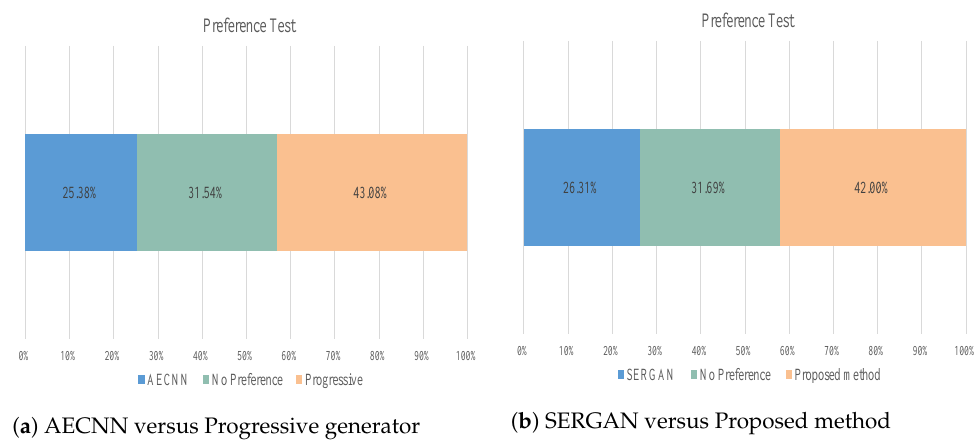
Figure 4. Results of AB preference test. A subset of test samples used in the evaluation is accessible on a webpage